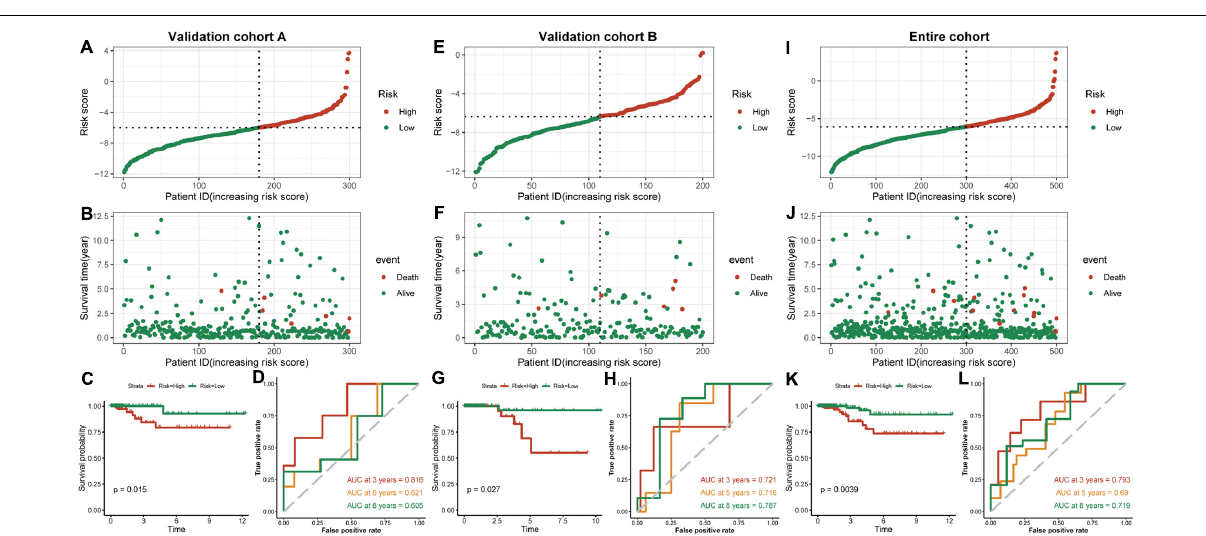
FIGURE 6 | Outcomes of a four-gene risk-scoring model in each cohort. Risk score analysis, Kaplan–Meier analysis and time-dependent ROC analysis in validation cohort A (A–D) . Risk score analysis, Kaplan–Meier analysis and time-dependent ROC analysis in validation cohort B (E–H) . Risk score analysis, Kaplan–Meier analysis and time-dependent ROC analysis in the entire cohort (I–L)